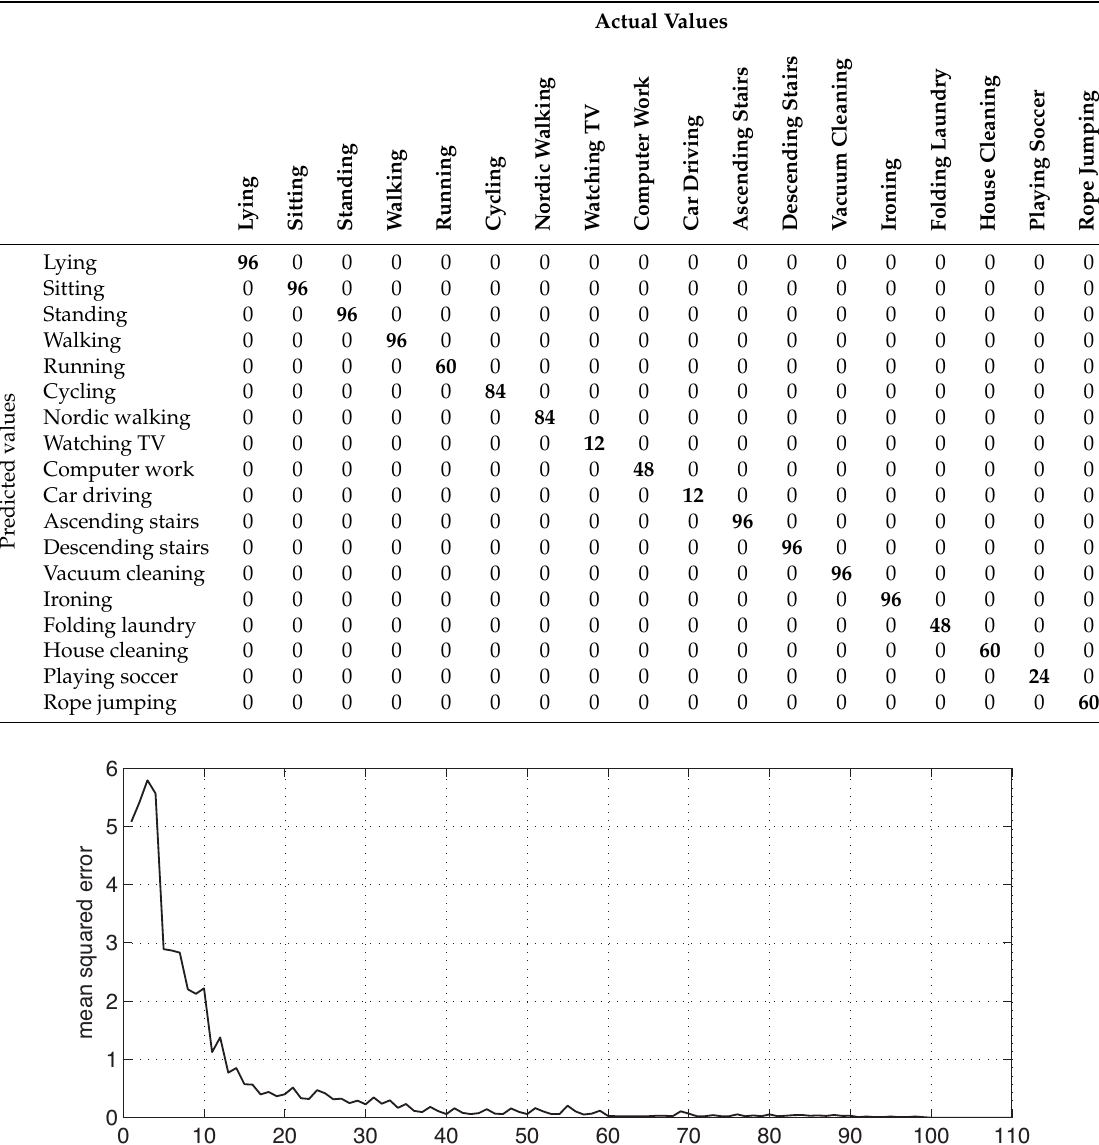
Table 14. Confusion matrix of the artificial hydrocarbon networks (AHN) classifier using a majority voting across windows-based approach (2.5-s window size).